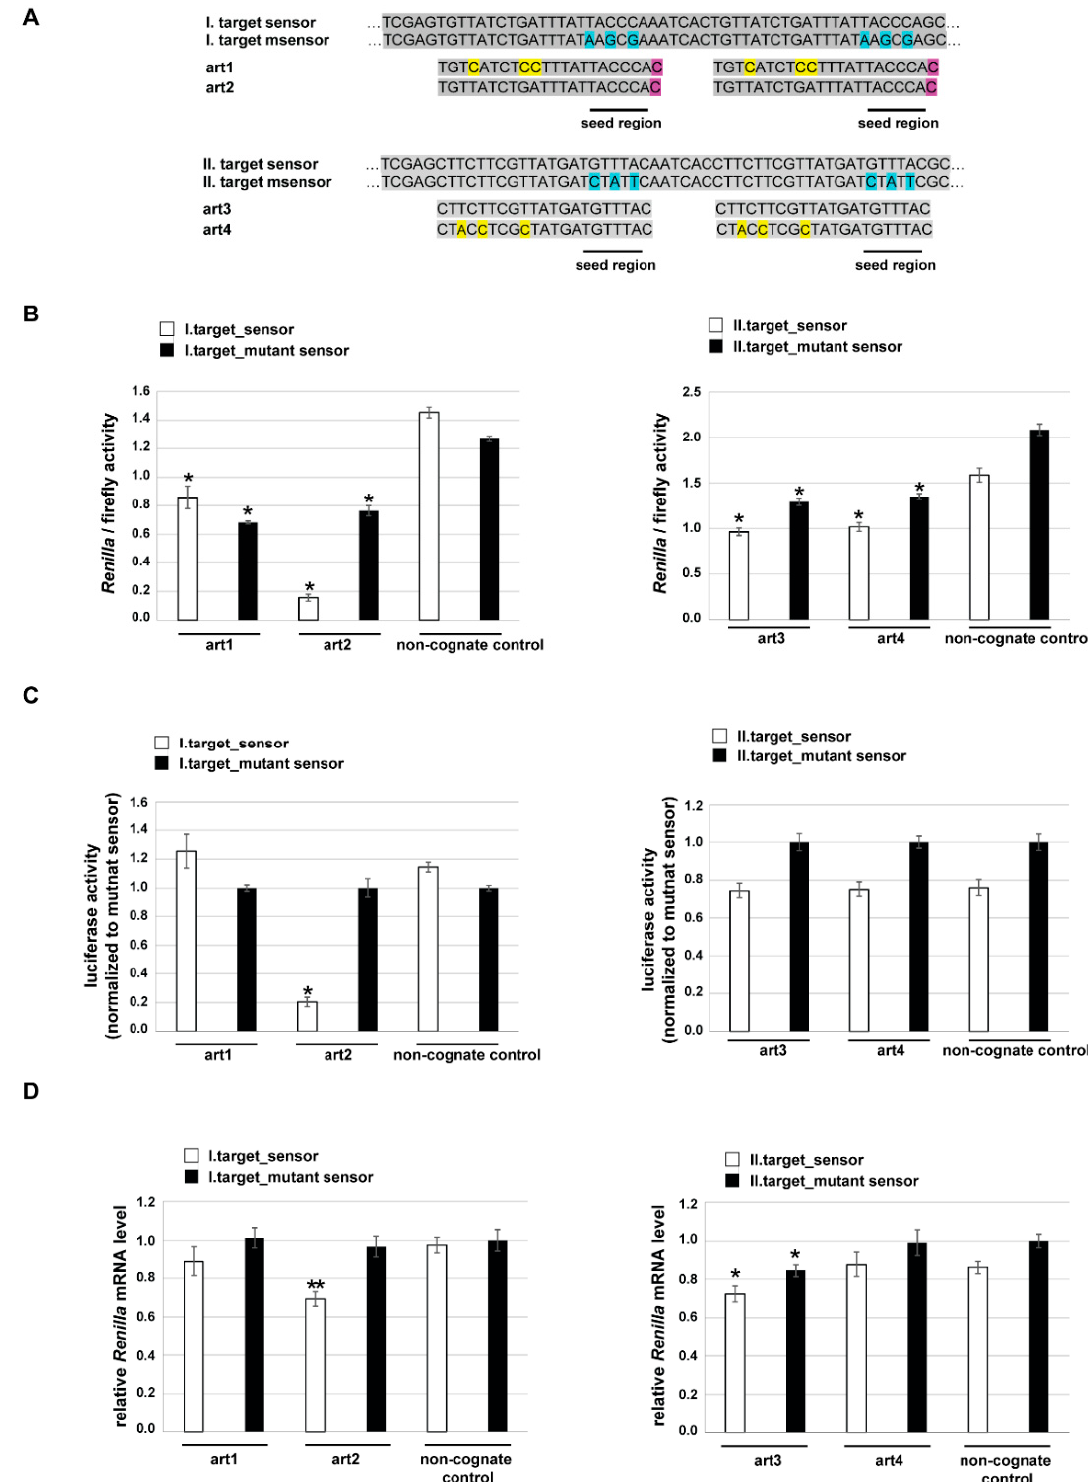
Figure 3. Testing the silencing ability of artificial mirtrons by luciferase assay. ( A ) DNA sequence alignment of luciferase targets and their respective artmirs (sense DNA sequences are shown). The psiCHECK2 vector-based sensor constructs contained two antisense copies of the particular target, cloned downstream of Renilla luciferase reporter. Sensors and mutant sensors (msensor) differ in 3 nucleotides in the potential seed region, indicated by the blue background. Art1 and art2 have a mismatch at their first position to the target since an extra G (its complementary ‘C’ in DNA is indicated by purple background) was added to their 5 ′ -end to fulfill mirtron criteria. Art3 is fully complementary to its sensor. Art1 and art4 have extra mismatches in their middle and 3 ′ -end regions (indicated by yellow background), compared to their counterparts, art2 and art3, respectively. ( B ) Dual-luciferase assay measurements to assess the silencing ability of the de- signed artmirs. Mean values of at least 3 parallel experiments are shown, and error bars represent standard deviations; *: